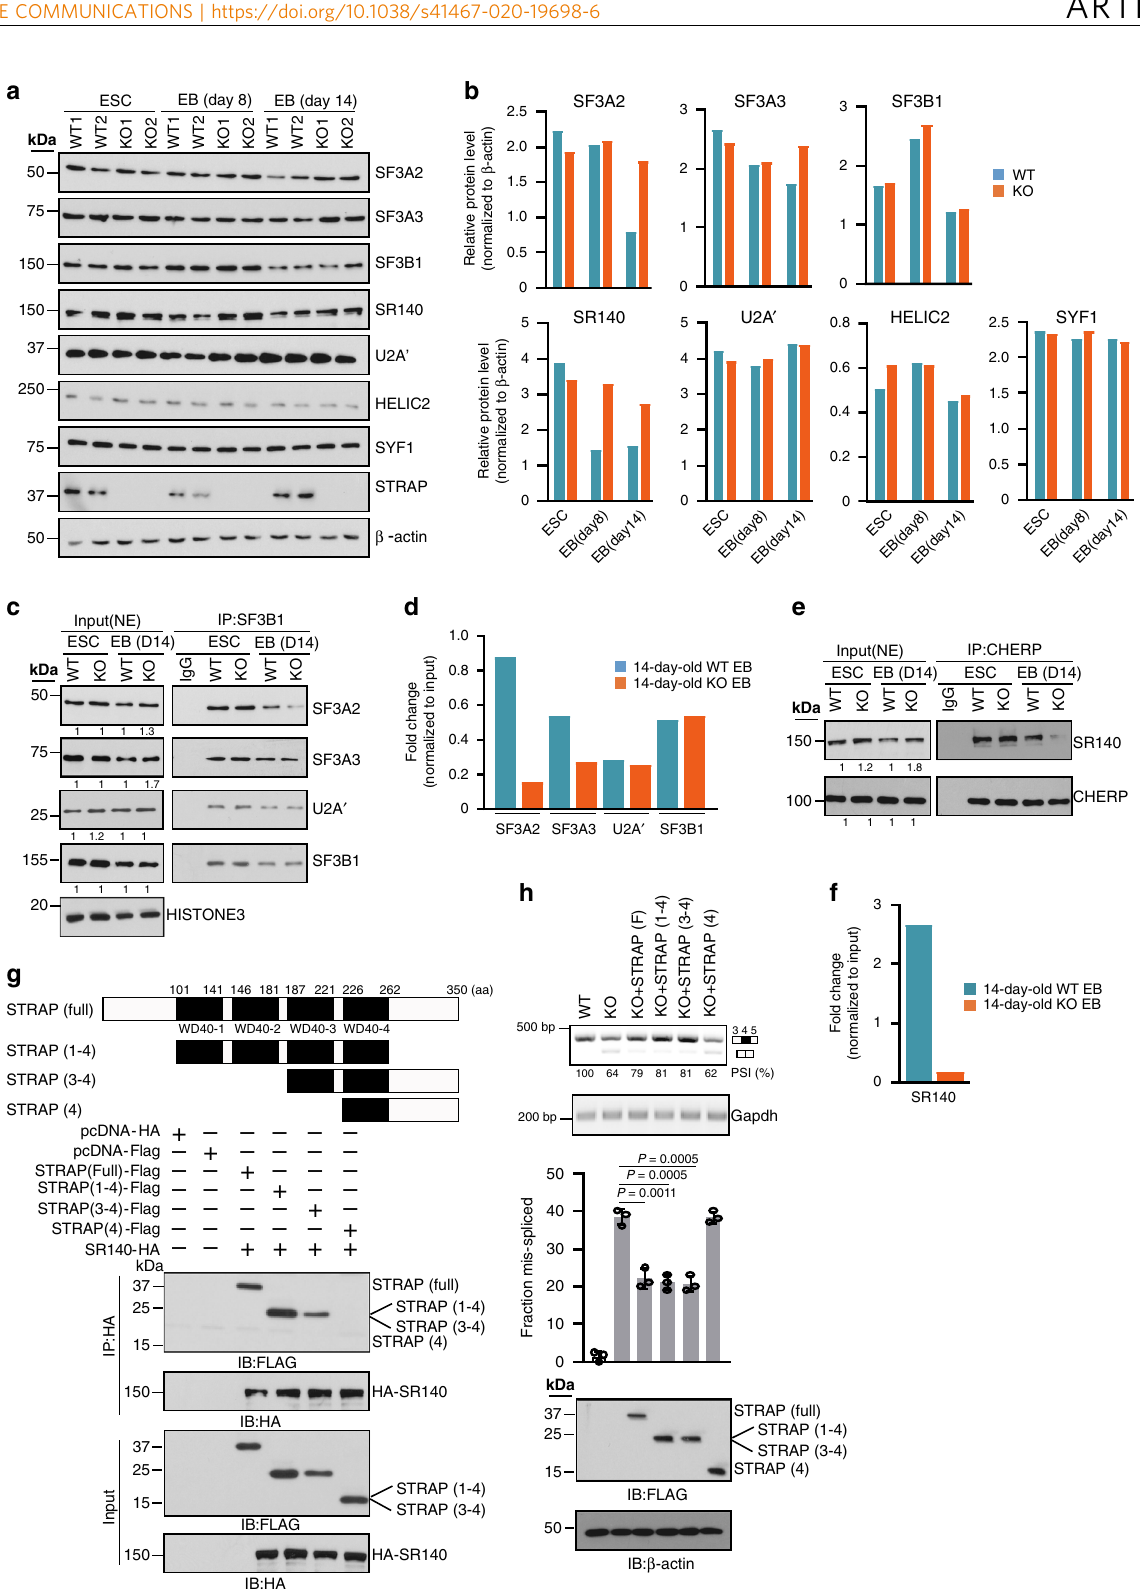
The XCalibur RAW fi les were further collected in pro fi le mode, centroided and converted to MzXML using ReAdW (version 3.5.1). The mgf fi les were then created using MzXML2Search (included in TPP v. 3.5) for all scans. The data was searched using SEQUEST (v.27 rec12. dta fi les), which was set for two maximum missed cleavages, a precursor mass window of 20 ppm, trypsin digestion, variable modi fi cation C @ 57.0293, and M @ 15.9949. Searches were performed with a species speci fi c subset of the UniRef100 database. The list of peptide IDs generated